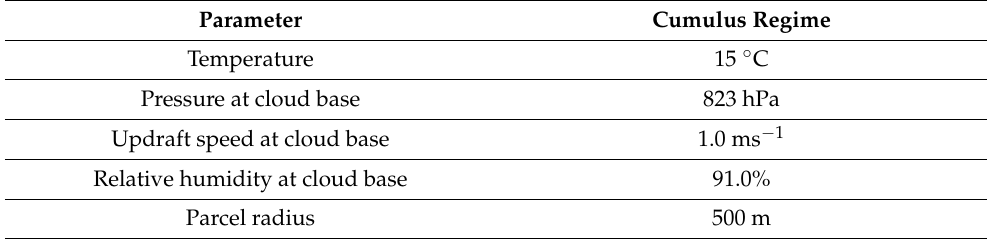
Table 1. Configuration of the chemical parcel model: key input variables.